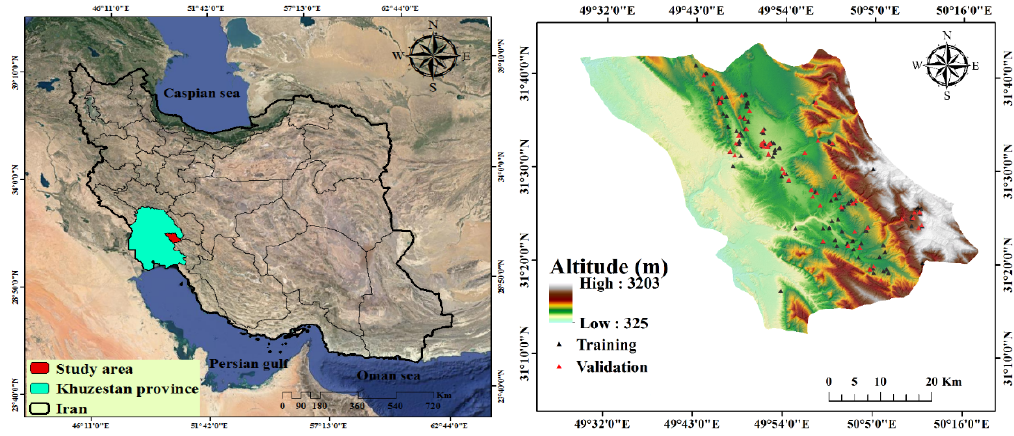
Figure 2. Study area with spring locations.